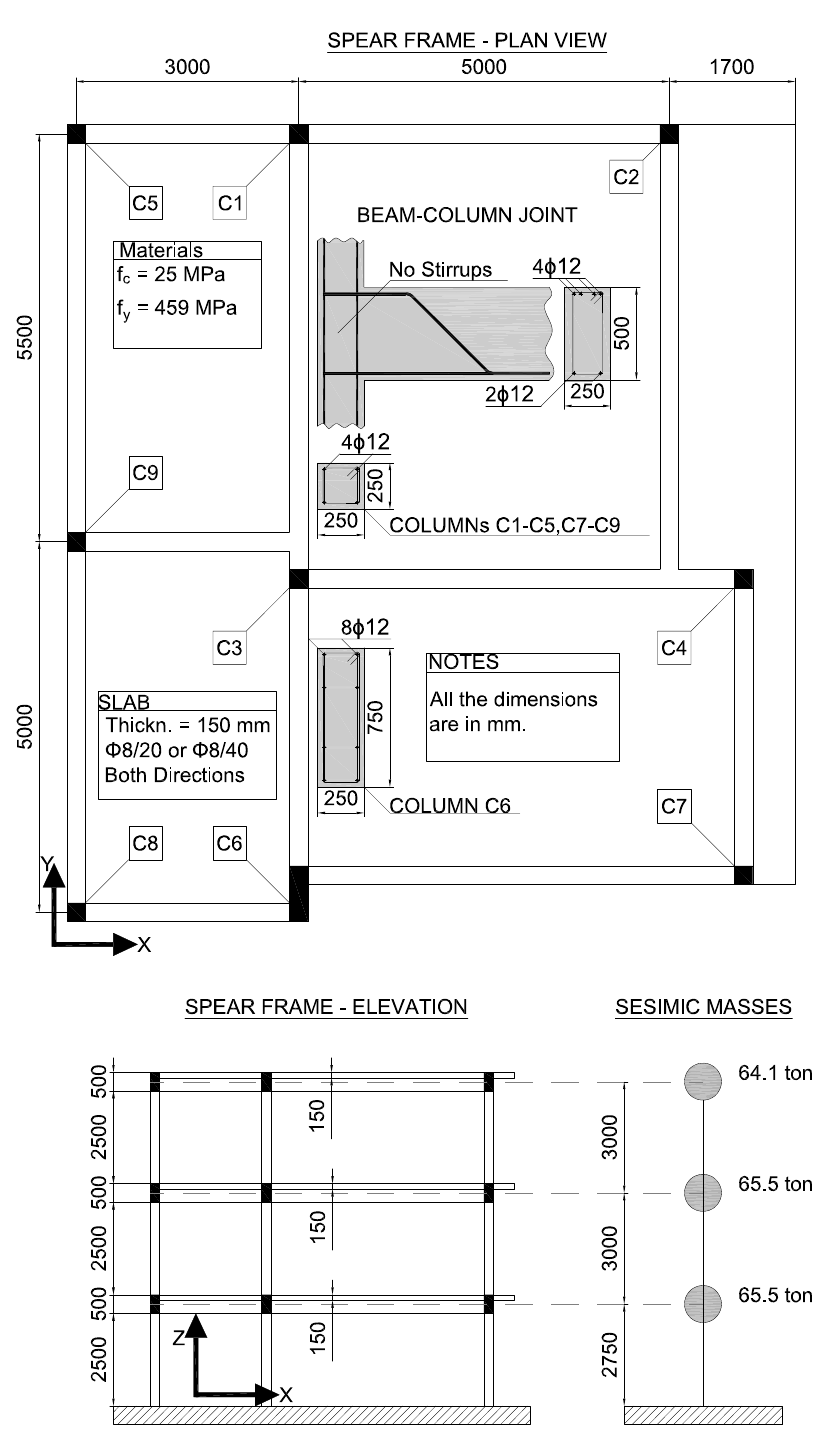
Figure 7. SPEAR frame